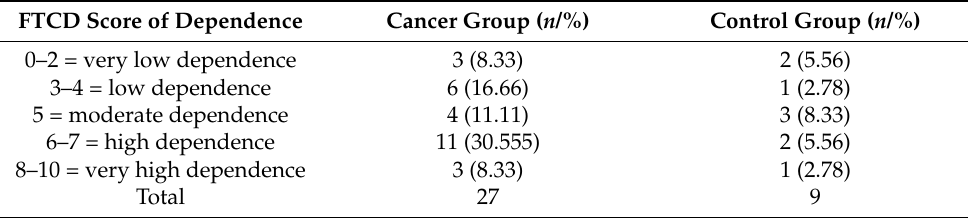
Table 2. Description of FTCD and AUDIT score results.